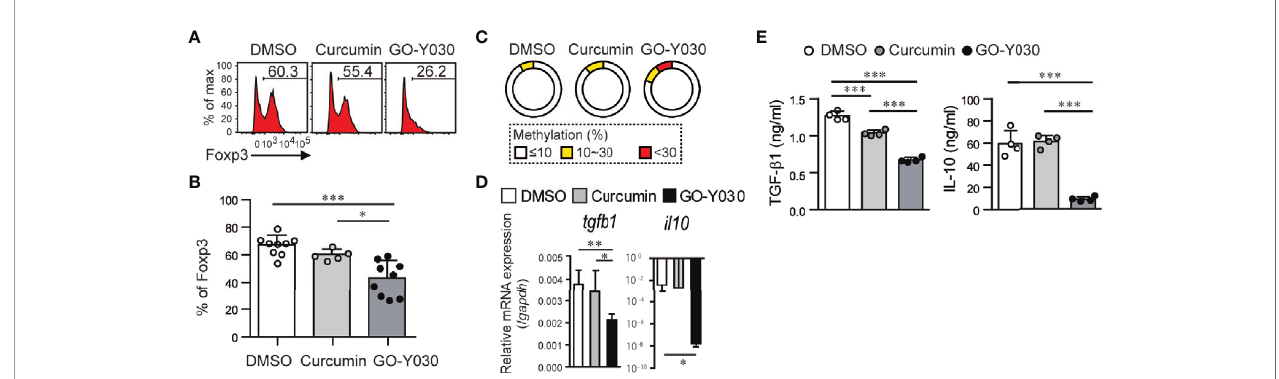
FIGURE 3 | GO-Y030 reduces the stability of Foxp3 expression in CD4 + CD25 + T cells. (A) Representative FACS plots of Foxp3 + cells. Splenic CD4 + CD25 + T cells were stimulated with anti-CD3 (1 µg/ml) and anti-CD28 (1 µg/ml) in the presence or absence of 1 µM curcumin or 0.25 µM GO-Y030 for 18 h. (B) The horizontal bars represent the mean and standard deviation. The data were pooled from at least four independent experiments in (A) . (C) Bisulfate sequencing of Foxp3 – CNS2 regions in cultured CD4 + CD25 + T cells for 18 h using anti-CD3 (1 µg/ml) and anti-CD28 (1 µg/ml) in the presence or absence of 1 µM curcumin or 0.25 µM GO-Y030. The parentage of CpG methylation status in the Foxp3-CNS2 regions is shown in the sector graphs; 9 – 11 cDNA clones were sequenced from each subset. The data are representative of at least two independent experiments. The color of the graph indicates the percentage of methylation in the Foxp3-CNS2 locus: white, 10% or less; yellow, above 10% but less than or equal to 30%; red, above 30%. (D) Relative tgfb1 and il10 expression (n = 4 – 8, mean ± standard deviation) by real-time PCR. The data were normalized to relative Gapdh expression. (E) TGF- b 1 production from cultured Tregs in the presence or absence of 1 µM curcumin or 0.25 µM GO-Y030 for 3 days. The graph shows the mean and standard deviation. A one-way ANOVA with post-hoc Tukey ’ s multiple comparisons test was applied (D, E) . *P< 0.05, **P < 0.01, ***P <